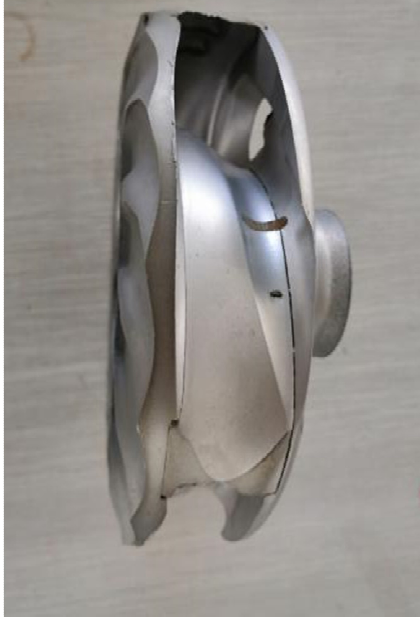
Figure 22. Photograph of the second-stage impeller wear.